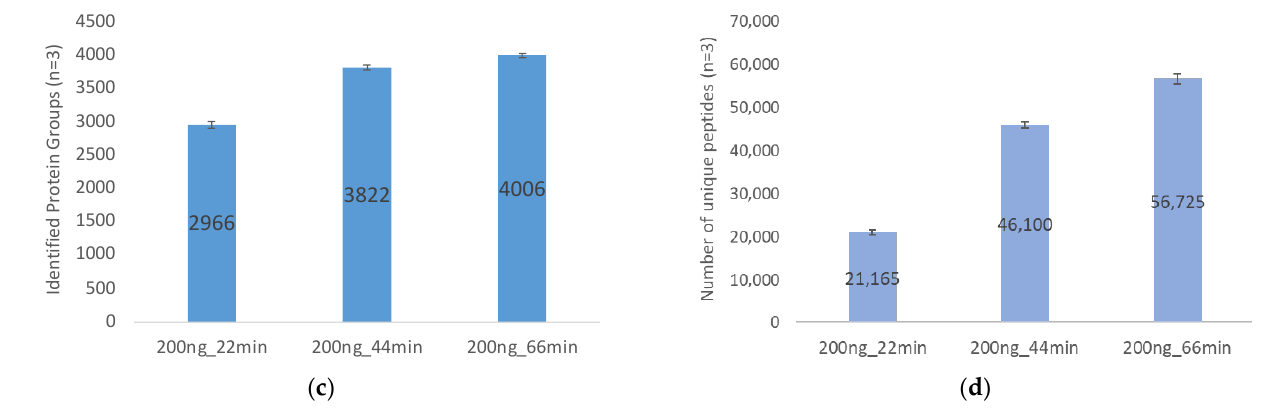
Figure 8. Proteome coverage compared to gradient. A comparison of gradient time course and HeLa digest loading amount is presented: ( a ) Identified protein groups using 100 ng of HeLa digest; ( b ) unique spectral counts using 100 ng of HeLa digest; ( c ) identified protein groups using 200 ng of HeLa digest; ( d ) unique spectral counts using 200 ng of HeLa digest. The mean and standard deviation of triplicate injections are shown for each of 3 gradient durations by search engines. (Note: 1. The search engine used was MSFragger; 2. In total, 200 ng datasets were collected using a different nanoLC column from that for 100 ng datasets, which explains why the 22 min gradient of 200 ng HeLa digest loading (Figure 8c,d) had lower number of protein groups and unique spectral counts identified than that of 100 ng of HeLa digest loading (Figure 8a,b)).